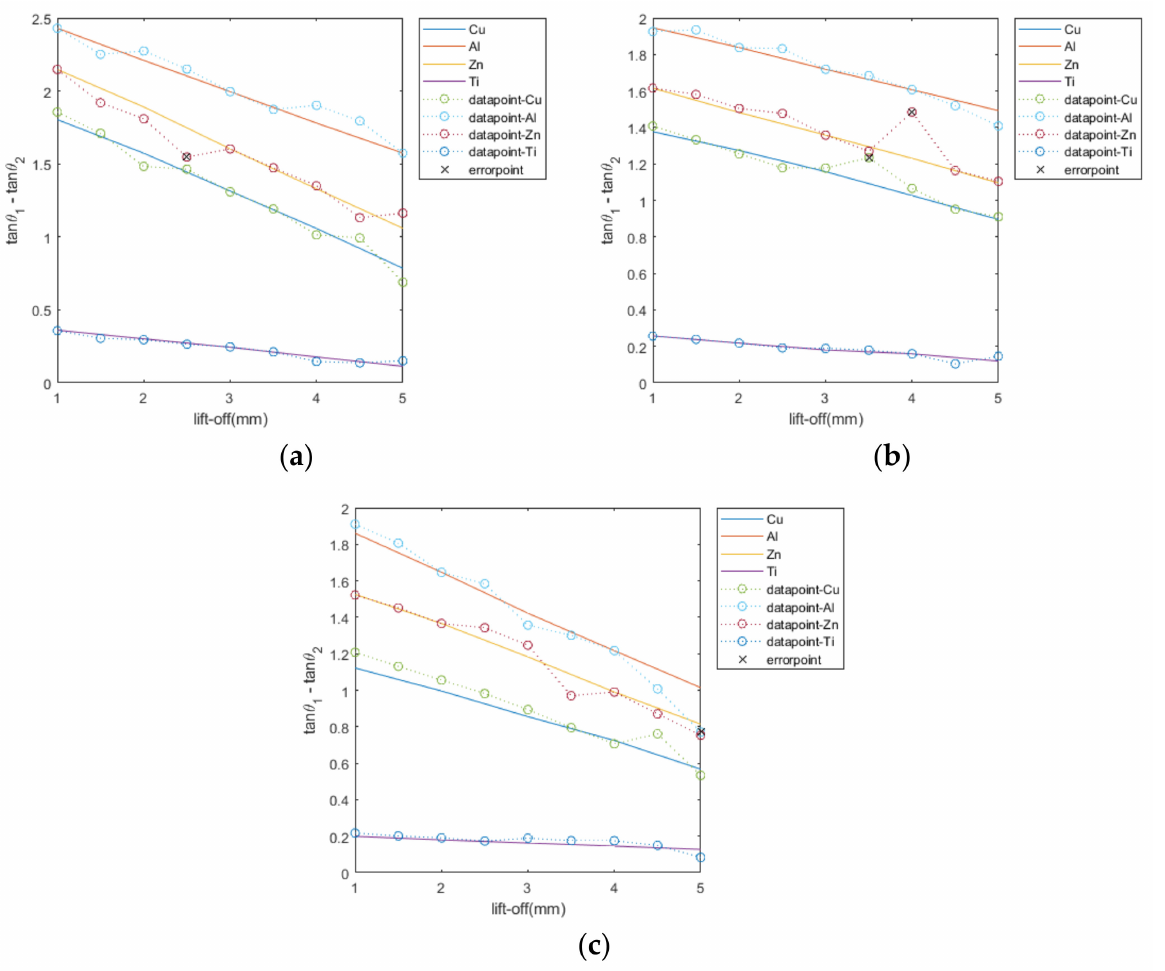
Figure 10. Experimental results. ( a ) plane ( b ) cylinder ( c )